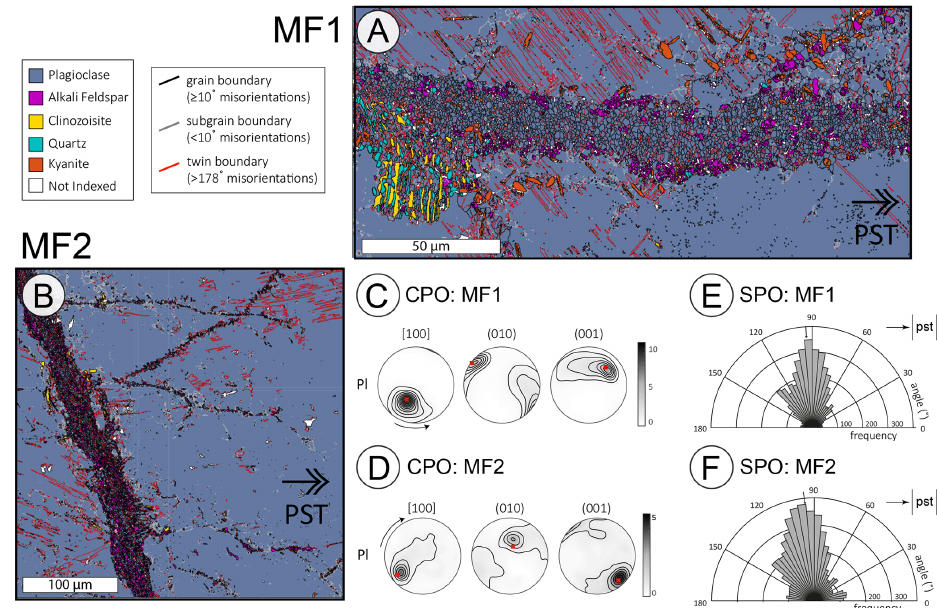
Figure 2. EBSD results of MF1 and MF2. Phase maps of (a) MF1 and (b) MF2. Pole figures of the plagioclase grains in (c) MF1 and (d) MF2. The red dot is the orientation of the host plagioclase. Rose diagrams of the long-axis distribution of the plagioclase grains in (e) MF1 and (f) MF2. The pseudotachylyte is to the right of all maps with vertical orientation. See Petley-Ragan et al. (2018) for more details on the EBSD methods and results.